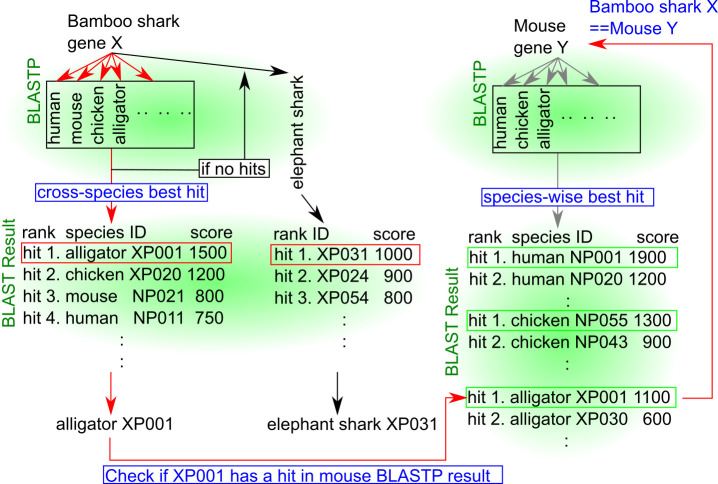
Schematic representation of the orthology assignment algorithm.Red arrows, the main flow of the algorithm. Black arrows, orthology assignment for cartilaginous fish-specific genes. Gray arrows, parallel retrieving of orthologs of mouse genes from other animals. Red rectangles, best hits across other animal genes or in elephantfish genes. Green rectangles, best hits among each animal genome. Note that this schematic explains how the orthology of abstract genes ‘bamboo shark gene X’ and ‘mouse gene Y’ are assigned. First, using BLASTP, putative orthologs of bamboo shark genes are retrieved from other animal genomes, such as human, mouse, alligator, and elephantfish. Then, all BLASTP results except those from elephantfish are concatenated to find a best scored gene across species (cross-species best hit). In this schematic, the alligator gene XP001 is the best hit. In parallel, putative orthologs of mouse genes are also retrieved from the same set of animal genomes. If there is a mouse gene Y that has a best hit with alligator XP001, this mouse gene Y and bamboo shark gene X are considered to be an orthologous pair.